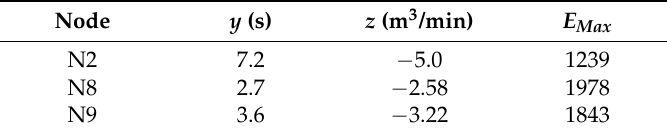
Table 4. Optimum operation parameters for candidate